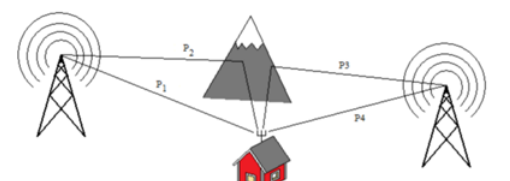
Figure 5. Signals at the input of the receive antenna in a single- frequency cluster.